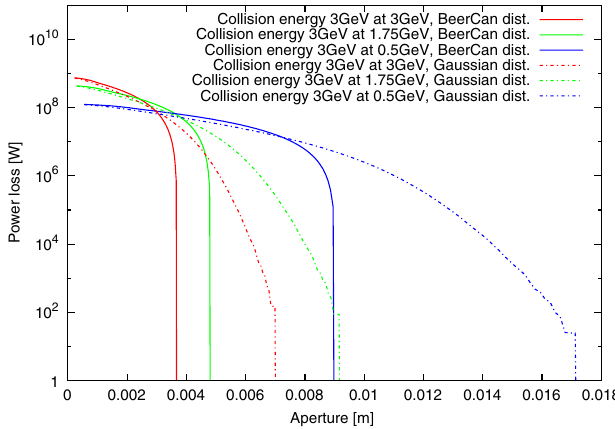
FIG. 16. (Color) Power loss at a given aperture and energy with the initial Gaussian distribution and Beer-Can distribution, low- energy setup (3 GeV collision energy).